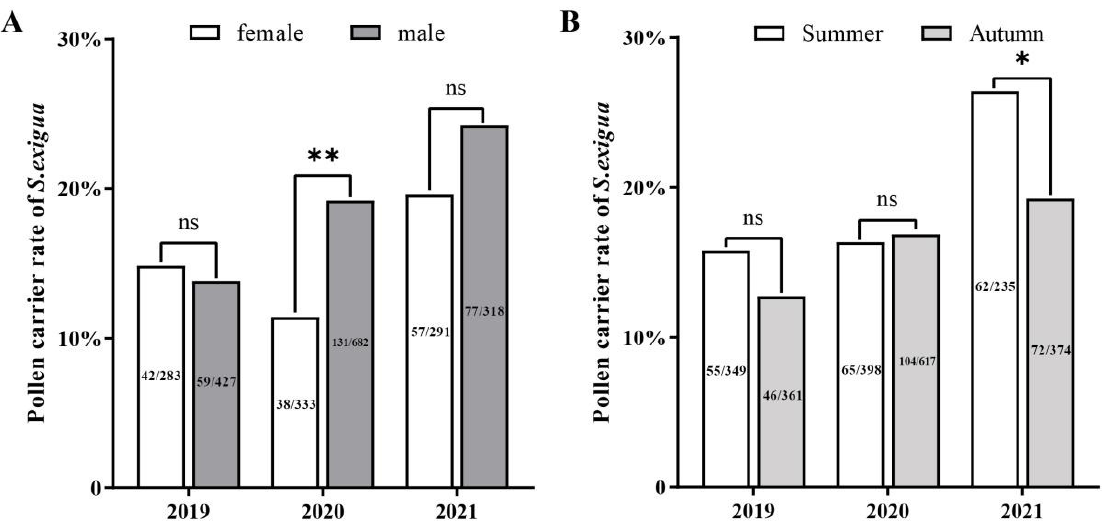
Figure 4. Frequencies of pollen deposition on migratory individuals of Spodoptera exigua among male and female moths ( A ) and different migration seasons ( B ) during 2019–2021. The numbers on the bar plots represent the number of adults with pollen/number of adults examined. * and ** stand for significant different at p < 0.05 and p < 0.01), respectively; ns: stand for no significant different. Similarly, the number of moths bearing pollen grains varied year-by-year. While the S. exigua moths trapped in summer (July–August) had a relatively higher pollen adher- ence ratio (18.5%, 182/982) than those trapped in autumn (September–October) (16.4%, 222/1352), the difference between the two seasons was not significant except in 2021 (2021: Chi-square; χ 2 = 4.277, df = 1, p = 0.0386) (Figure 4B).